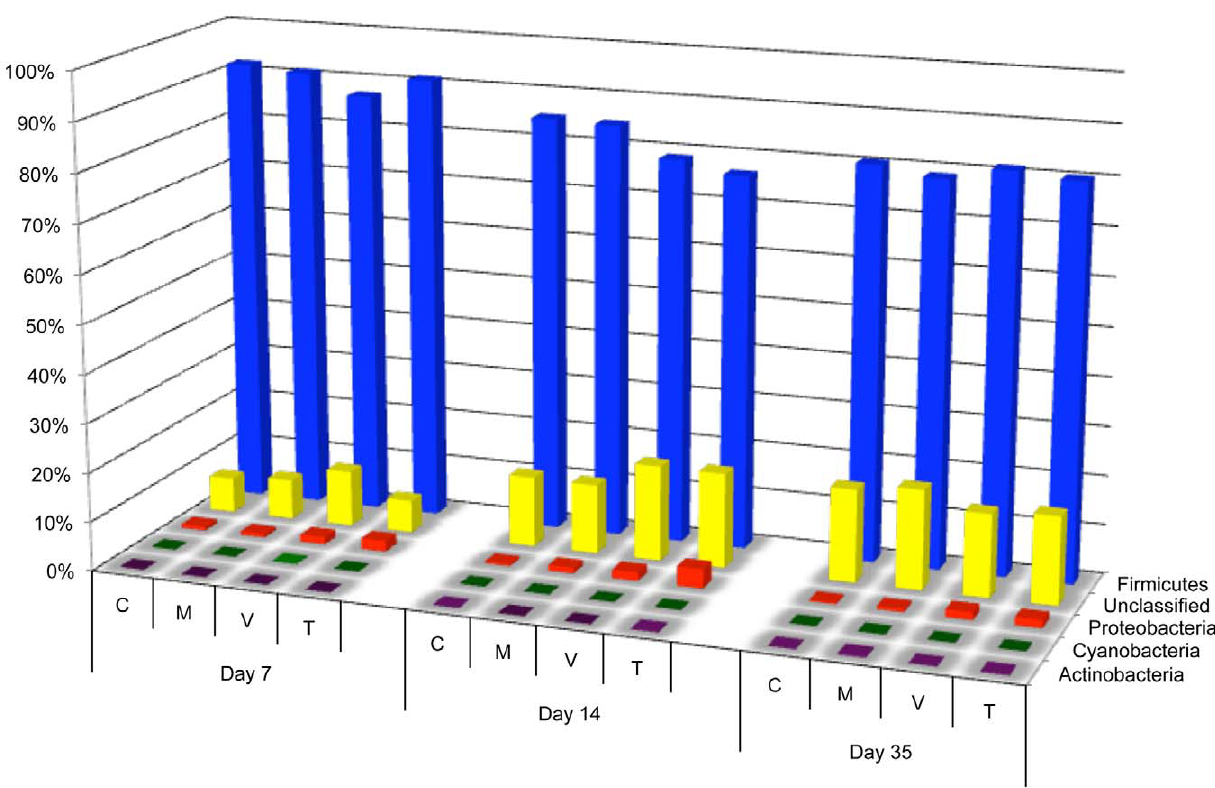
Figure 1. Bacterial phyla distributions at the three timepoints after the start of treatments, using V3 amplicon sequencing (n=89,652). For each timepoint, C = control diet, M = monensin treatment, V = monensin/virginiamycin treatment, and T = monensin/tylosin treatment.